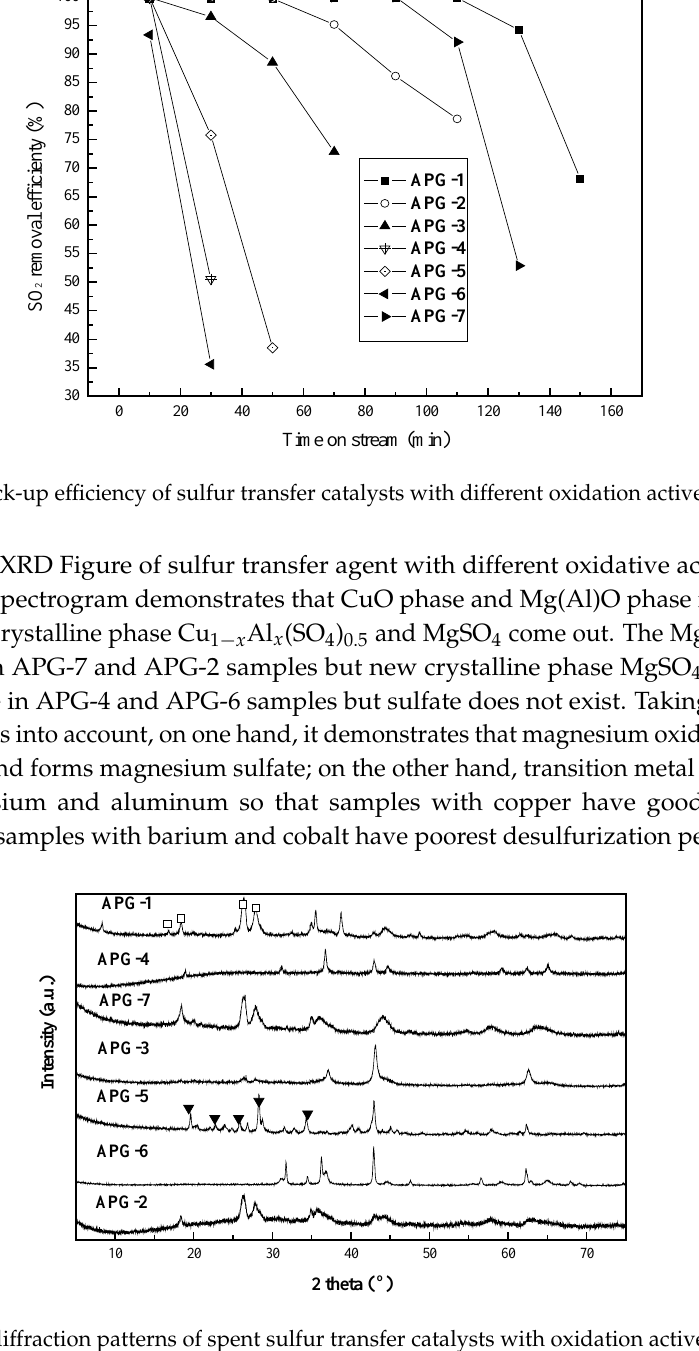
Figure 5. X-ray diffraction patterns of spent sulfur transfer catalysts with oxidation active components: □: Cu 1− x Al x (SO 4 ) 0.5 ; ▼:MgSO 4 .